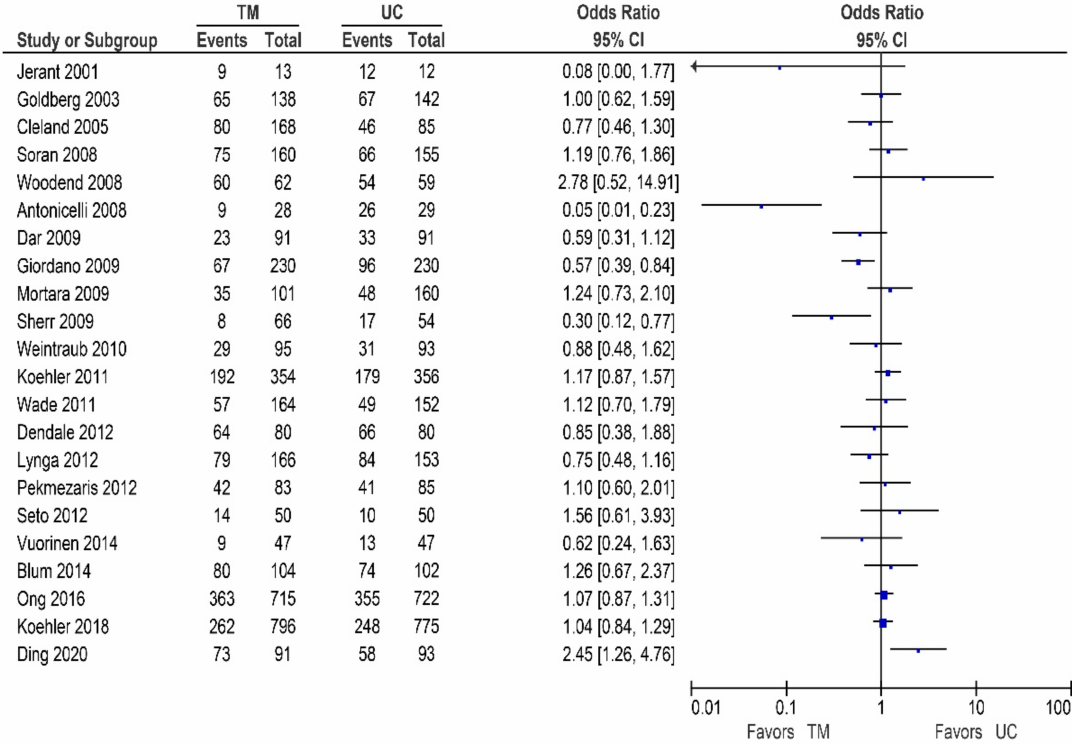
Figure 5. All-cause hospitalization in patients receiving non-invasive telemonitoring versus usual care.